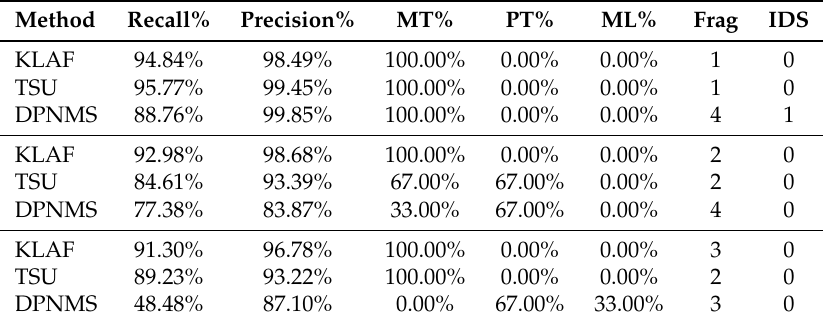
Table 1. Comparative results for our dataset with metrics proposed in